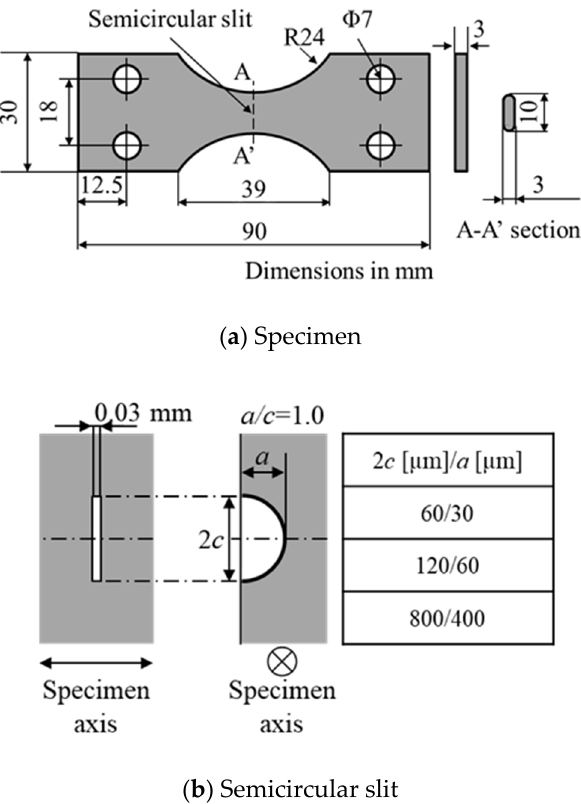
Figure 4. Shape and dimensions of the test specimens and the semicircular slit. ( a ) specimen ( b ) semicircular slit.